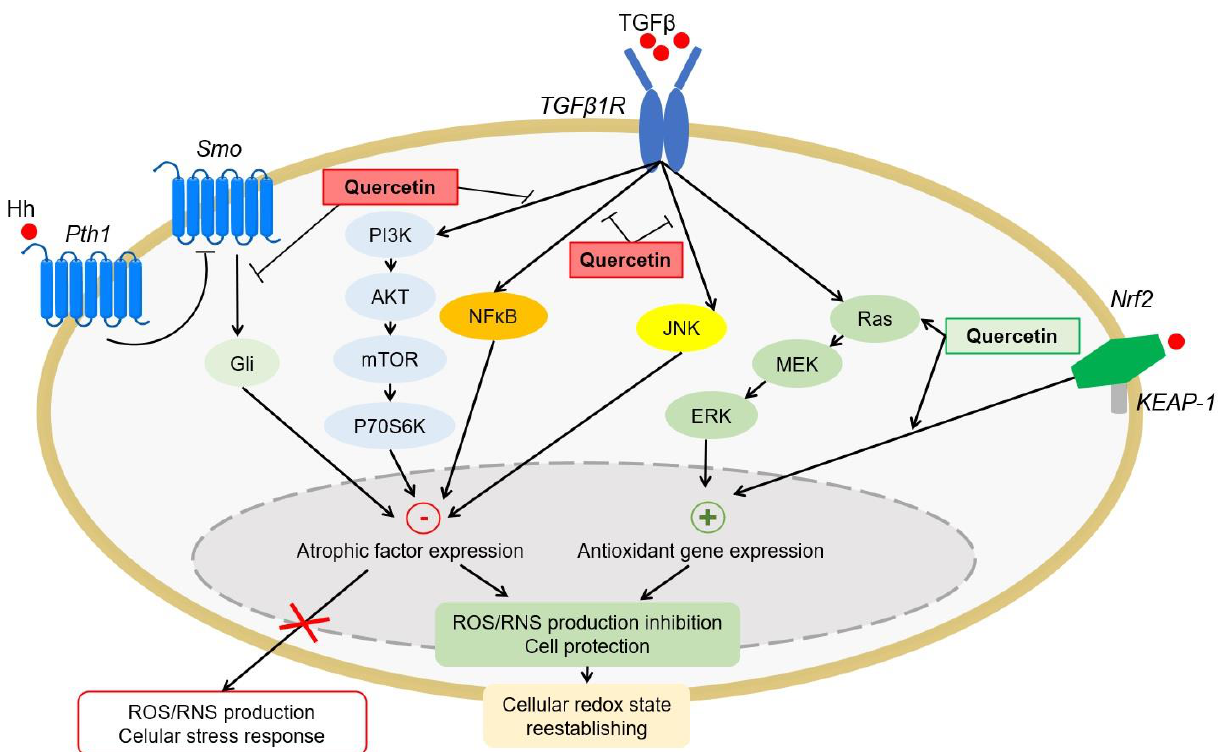
Figure 4. Effect of quercetin on the regulation of molecular mechanisms induced by oxidative stress. Quercetin inhibits the Hedgehog, PI3K/AKT, JNK, and NF- κ B signaling pathways. Furthermore, quercetin induces the MAP kinases and Nrf2 signaling pathways. As a consequence, there is an increase in the expression of antioxidant enzymes and the production of ROS is inhibited, reestablishing the cellular redox state. +: indicates induction; -: indicates inhibition.